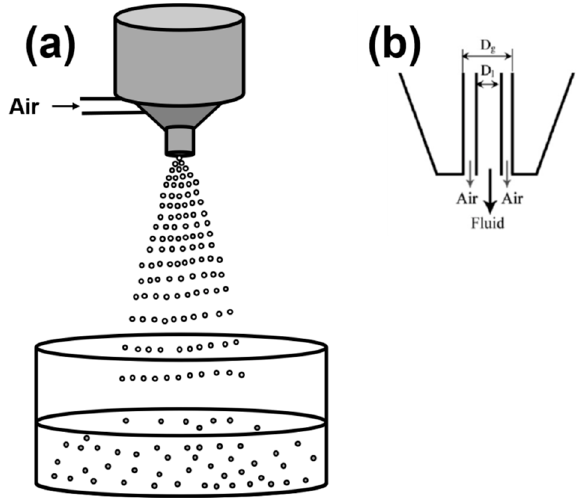
Figure 5. Scheme showing atomization of a solution ( a ). The atomizer nozzle ( b ) showing one of the example used for the production of κ -carrageenan gel particles using atomizing technique. Dl is the diameter of the fluid nozzle exit and Dg is the diameter of the gas nozzle exit; reproduced with permission from reference [86].